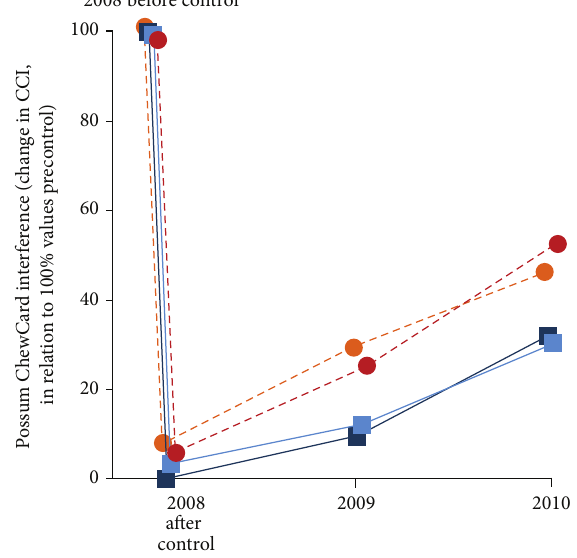
Figure 2: Changes in possum relative abundance indices, as deter- mined by measuring changing levels of ChewCard interference, in four blocks on Molesworth Station, following aerial poisoning of possumsinOctober2008.Redlinesrefertoreducedcoverageblocks ( 𝑛 = 2 ); blue lines refer to normal coverage blocks ( 𝑛 = 2